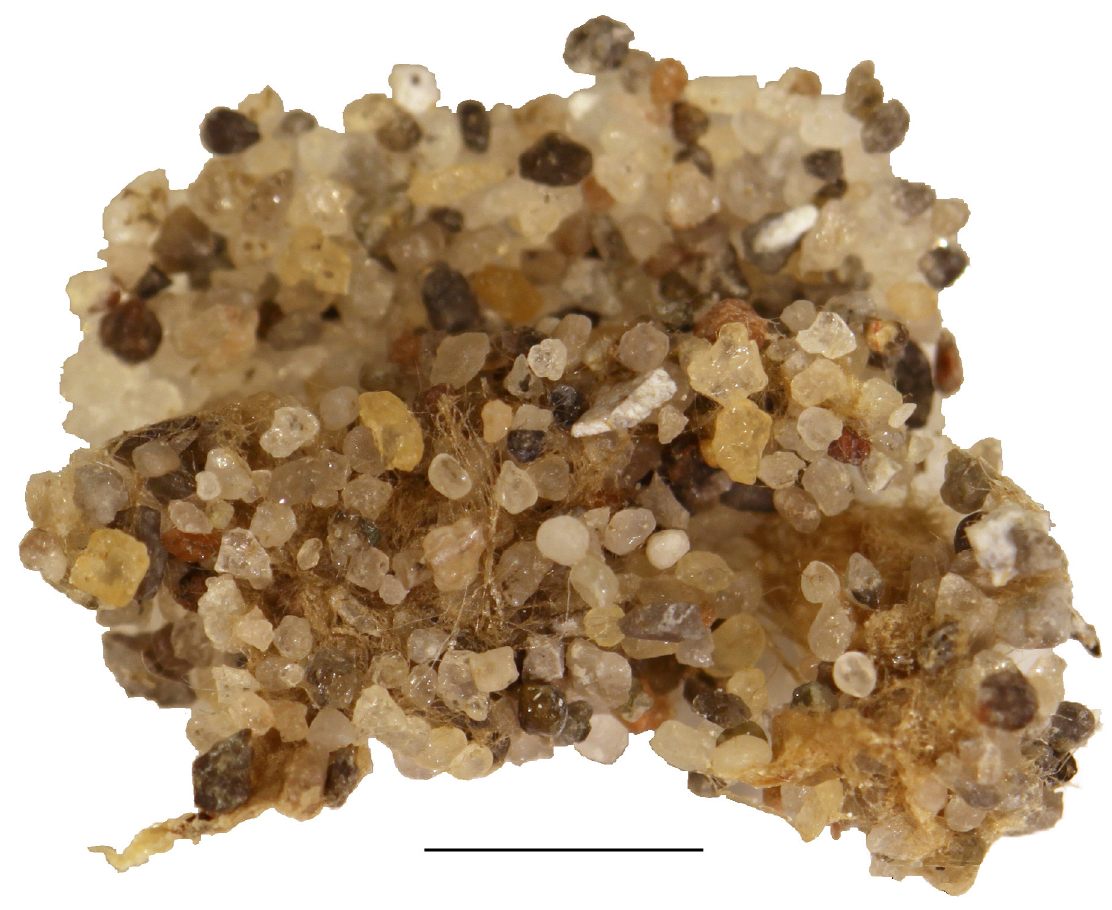
Fig. 2. Modiolus cimbricus sp. nov. A 17.5 mm long specimen in its ball of sand grains. This specimen has been cultured for five years. Scale bar = 5